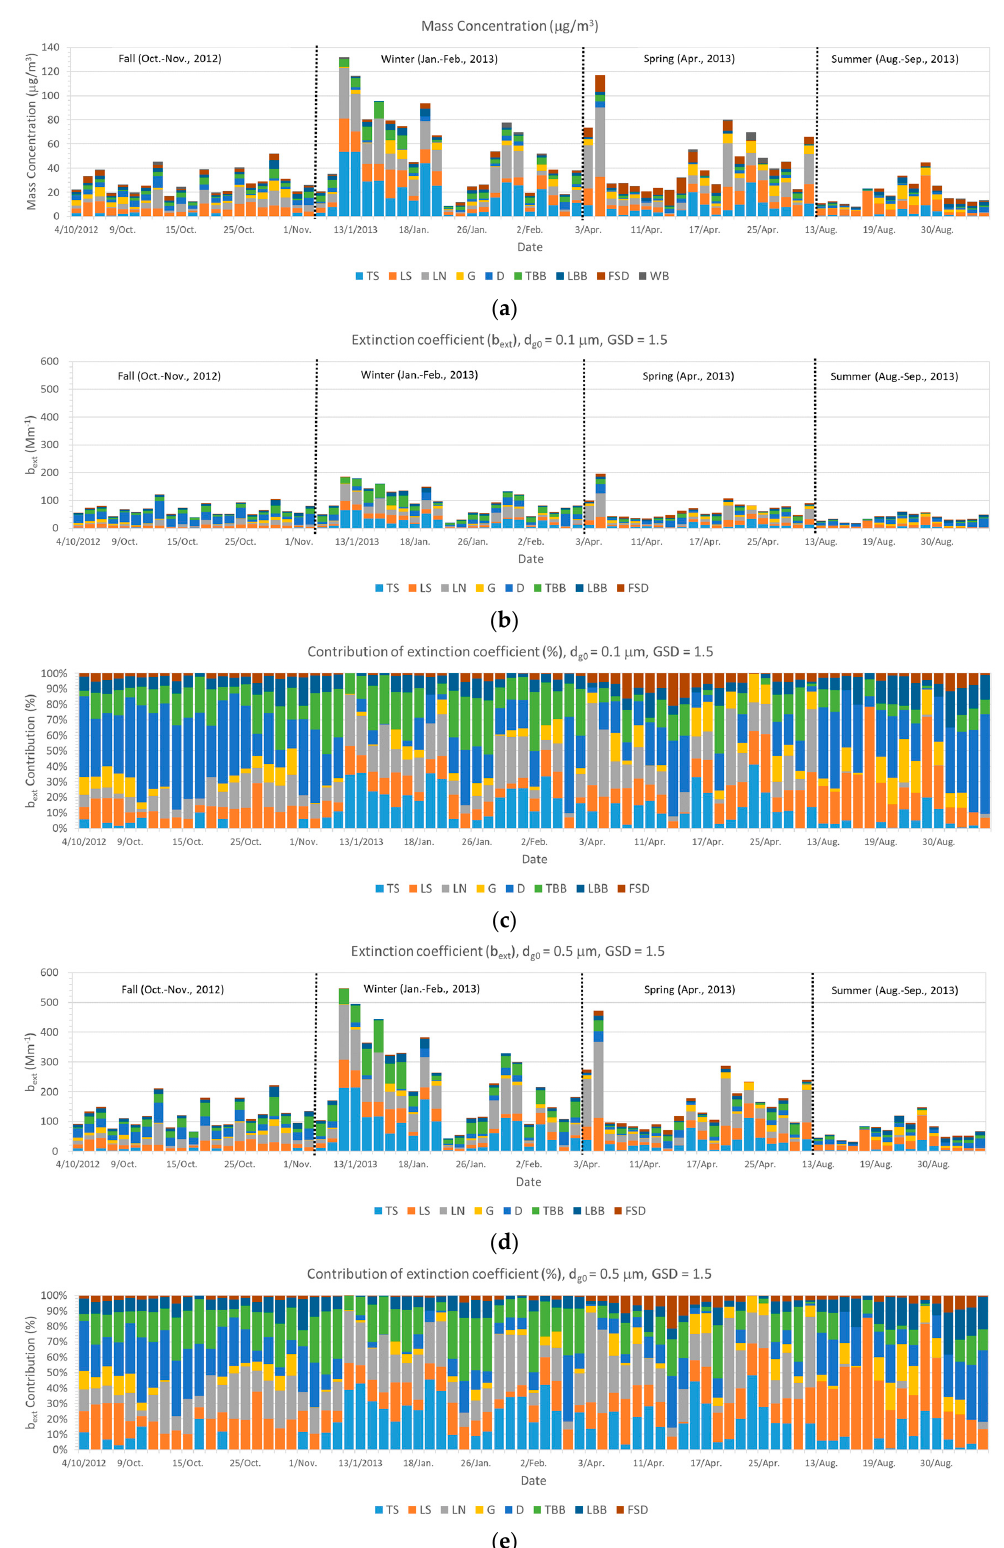
Figure 6. ( a ) Source-based mass concentrations, ( b ) source-based extinction coefficients (d g = 0.1 µm, GSD = 1.5), ( c ) contribution of the source-based extinction coefficients (d g = 0.1 µm, GSD = 1.5), ( d ) source-based extinction coefficients (d g = 0.5 µ m, GSD = 1.5), and ( e ) contribution of source-based extinction coefficients (d g = 0.5 µ m, GSD = 1.5) during sampling